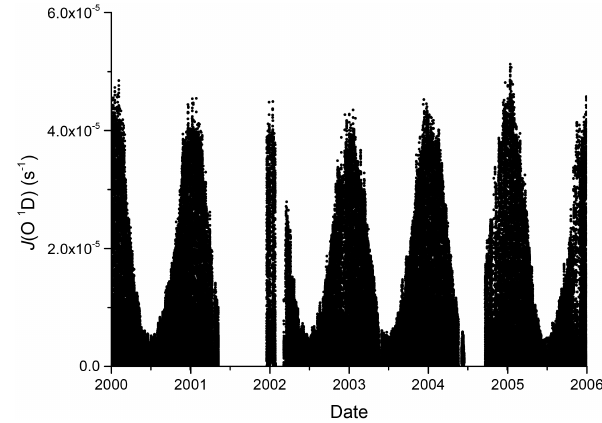
Figure 2. Photolysis rate J (O 1 D) observed at Cape Grim 2000– 2005. Gaps in the data are due to instrument failure. Date markers indicate the beginning of each